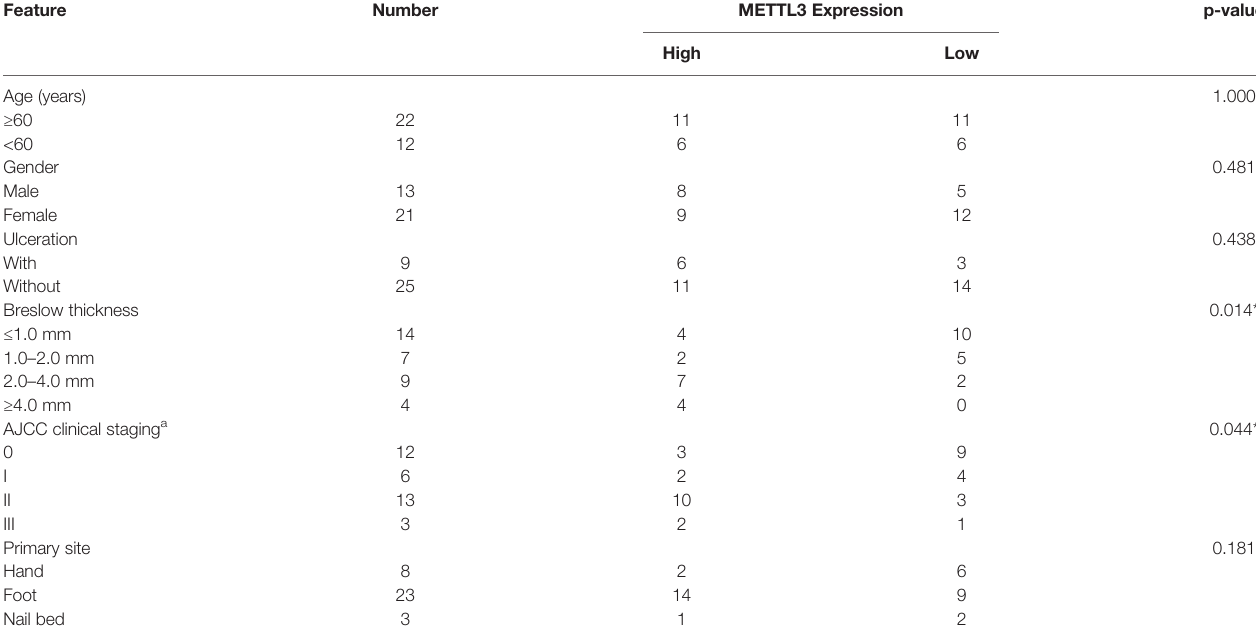
TABLE 1 | Correlation between METTL3 expression and clinicopathologic features of acral melanoma patients (n = 34).